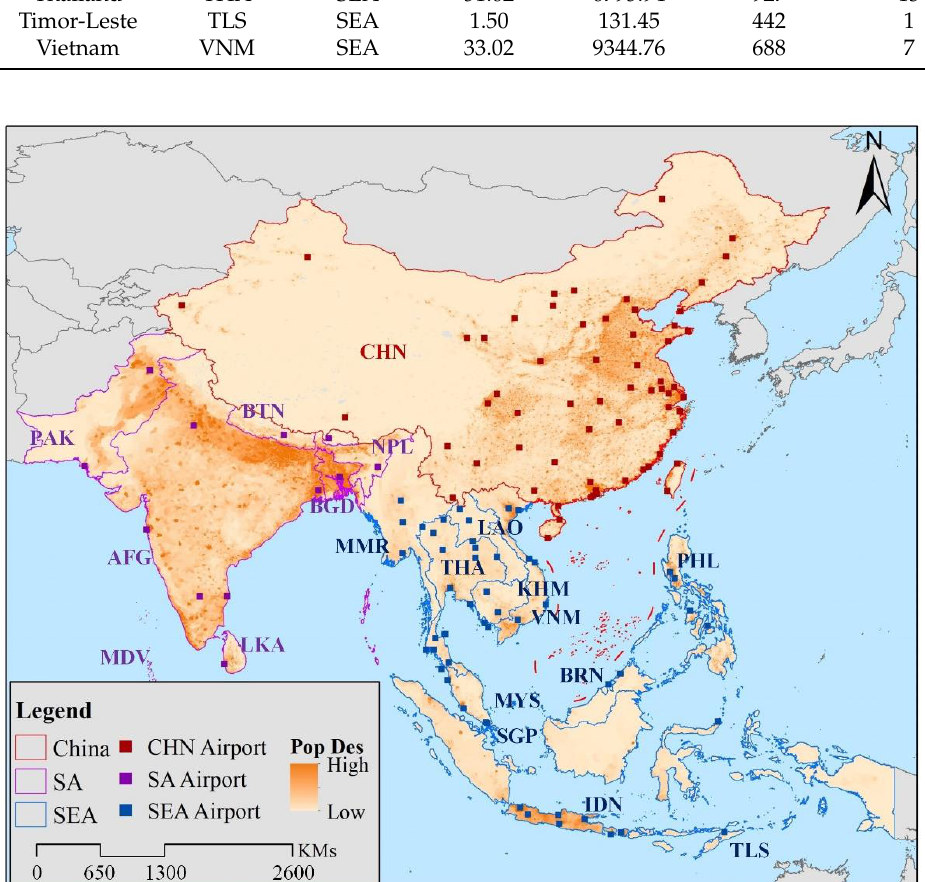
Figure 2. The spatial distribution of the 65 busiest airports in China (including Hong Kong, Macao, and Taiwan), and the main 63 navigable airports in South Asia (SA) and Southeast Asia (SEA). The grid population data is also shown for better representation than residential point data [46]. The figure is under WGS-84 geographical coordinate system.